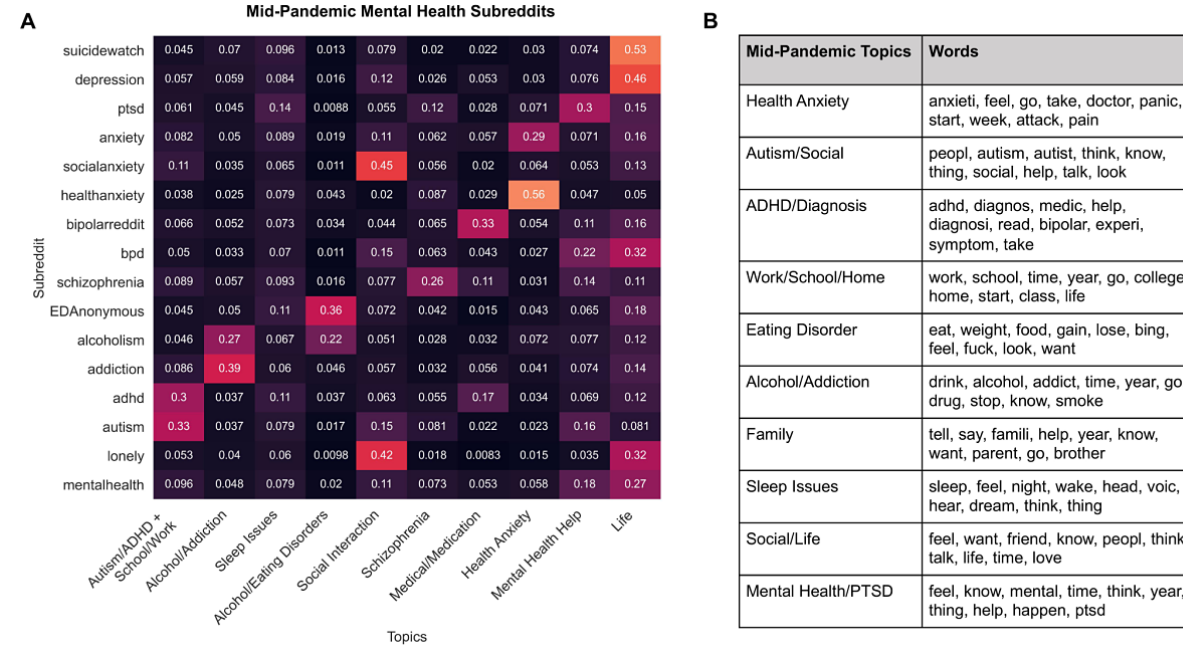
Figure 4. Latent dirichlet allocation (LDA) reveals prominent topics in mental health subreddits. A) Distribution of midpandemic posts from 15 mental health subreddits across 10 topics extracted using LDA on prepandemic mental health subreddit posts. Topic distribution was assessed for midpandemic posts between March 16, 2020, and April 20, 2020, to capture the phase of the pandemic right after stay-at-home orders had been announced or enacted for many areas in the United States. Inspection of the topic distribution indicated that there was minimal shift in most topics for all subreddits between the pre- and midpandemic time frames. We tested changes in topic distributions across all 27 subreddits using a Wilcoxon signed rank test (COVID19_support was not available during 2019). B) Manually labelled topics and the top 10 terms associated with each topic derived from an